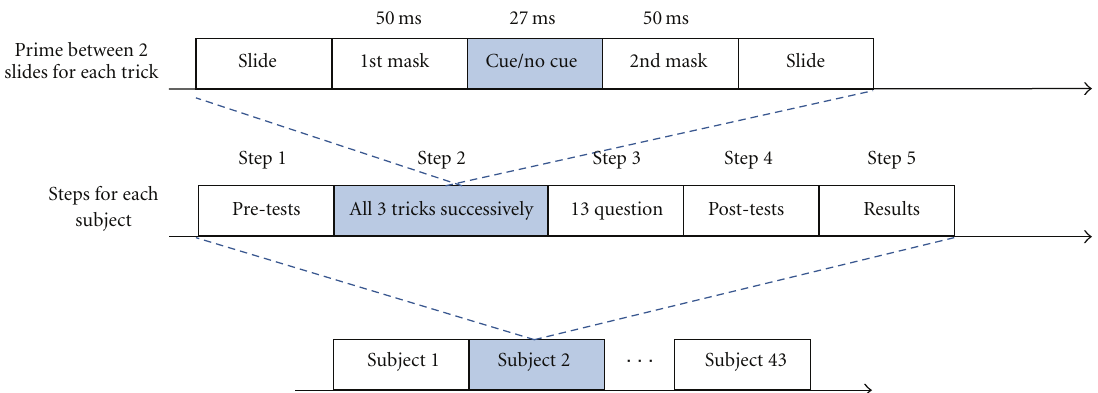
Figure 3: Experiment design in 5 steps shown above.